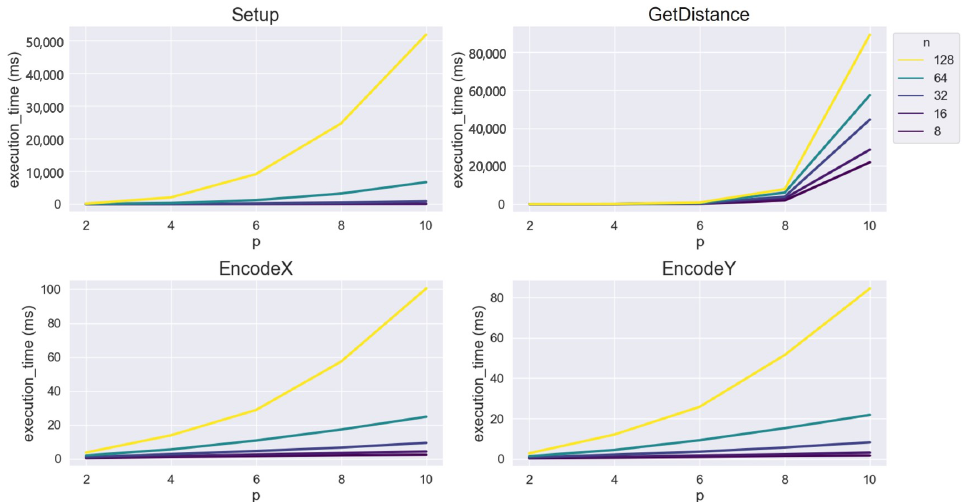
Figure 1. Execution time (ms) of the operations of ∏ PDIST on a desktop